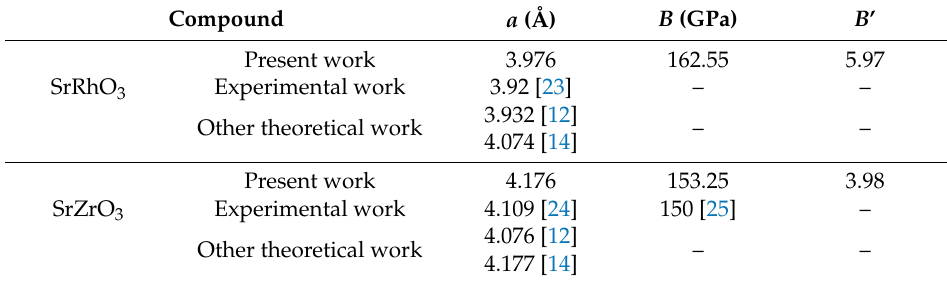
Figure 2. Total energy as a function of the volume of ( a ) SrRhO 3 compound and ( b ) SrZrO 3 compound. Table 1. Calculated lattice parameter ( a ), bulk modulus ( B ), first pressure derivative ( B ’) of SrTMO 3 (TM-Rh,